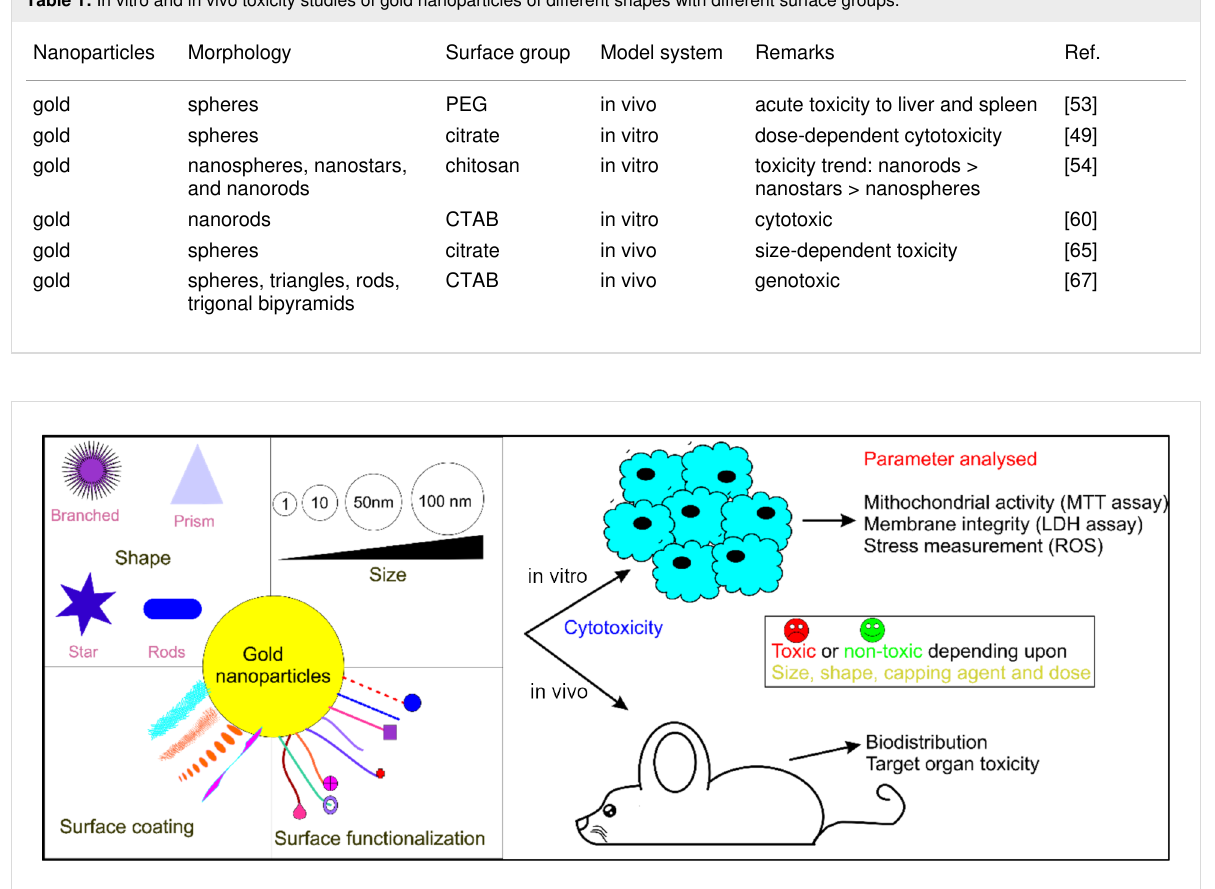
Figure 2: Cytotoxicity of anisotropic gold metal nanoparticles in vitro and in vivo.